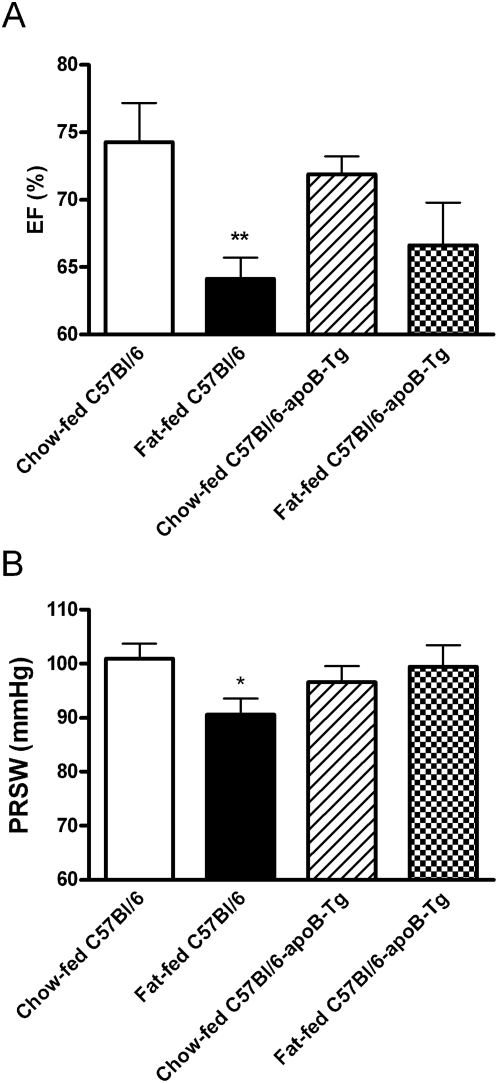
Overexpression of human apoB in the heart attenuates deterioration of cardiac function in fat-fed obese mice.Heart function was determined with a conductance catheter placed in the left cardiac ventricle A) EF, ejection fraction, B) PRSW, preload recruitable stroke work. Open bars: chow-fed C57Bl/6 mice (n = 7), closed bars: fat-fed C57Bl/6 mice (n = 7), hatched bars: chow-fed C57Bl/6-apoB-Tg mice (n = 11), squared bars: fat-fed C57Bl/6-apoB-Tg mice (n = 7). Values are mean±SEM after 11 months on the diets. The p values for two-group comparisons are: * P<0.05, ** P≤0.01.